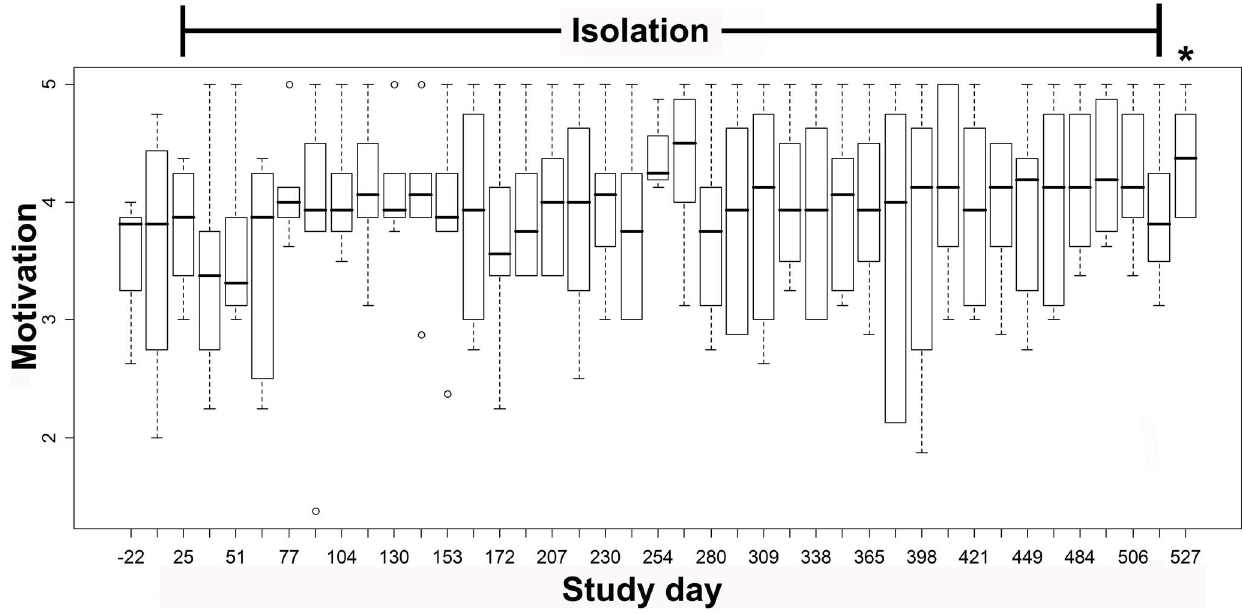
Figure 5. Boxplots of subjective motivation level over the course of isolation. Non-parametric form of repeated measures analysis of variance showed no significant changes over time ( p =0.20). *: p =0.045 on Wilcoxon-test versus pre-isolation.